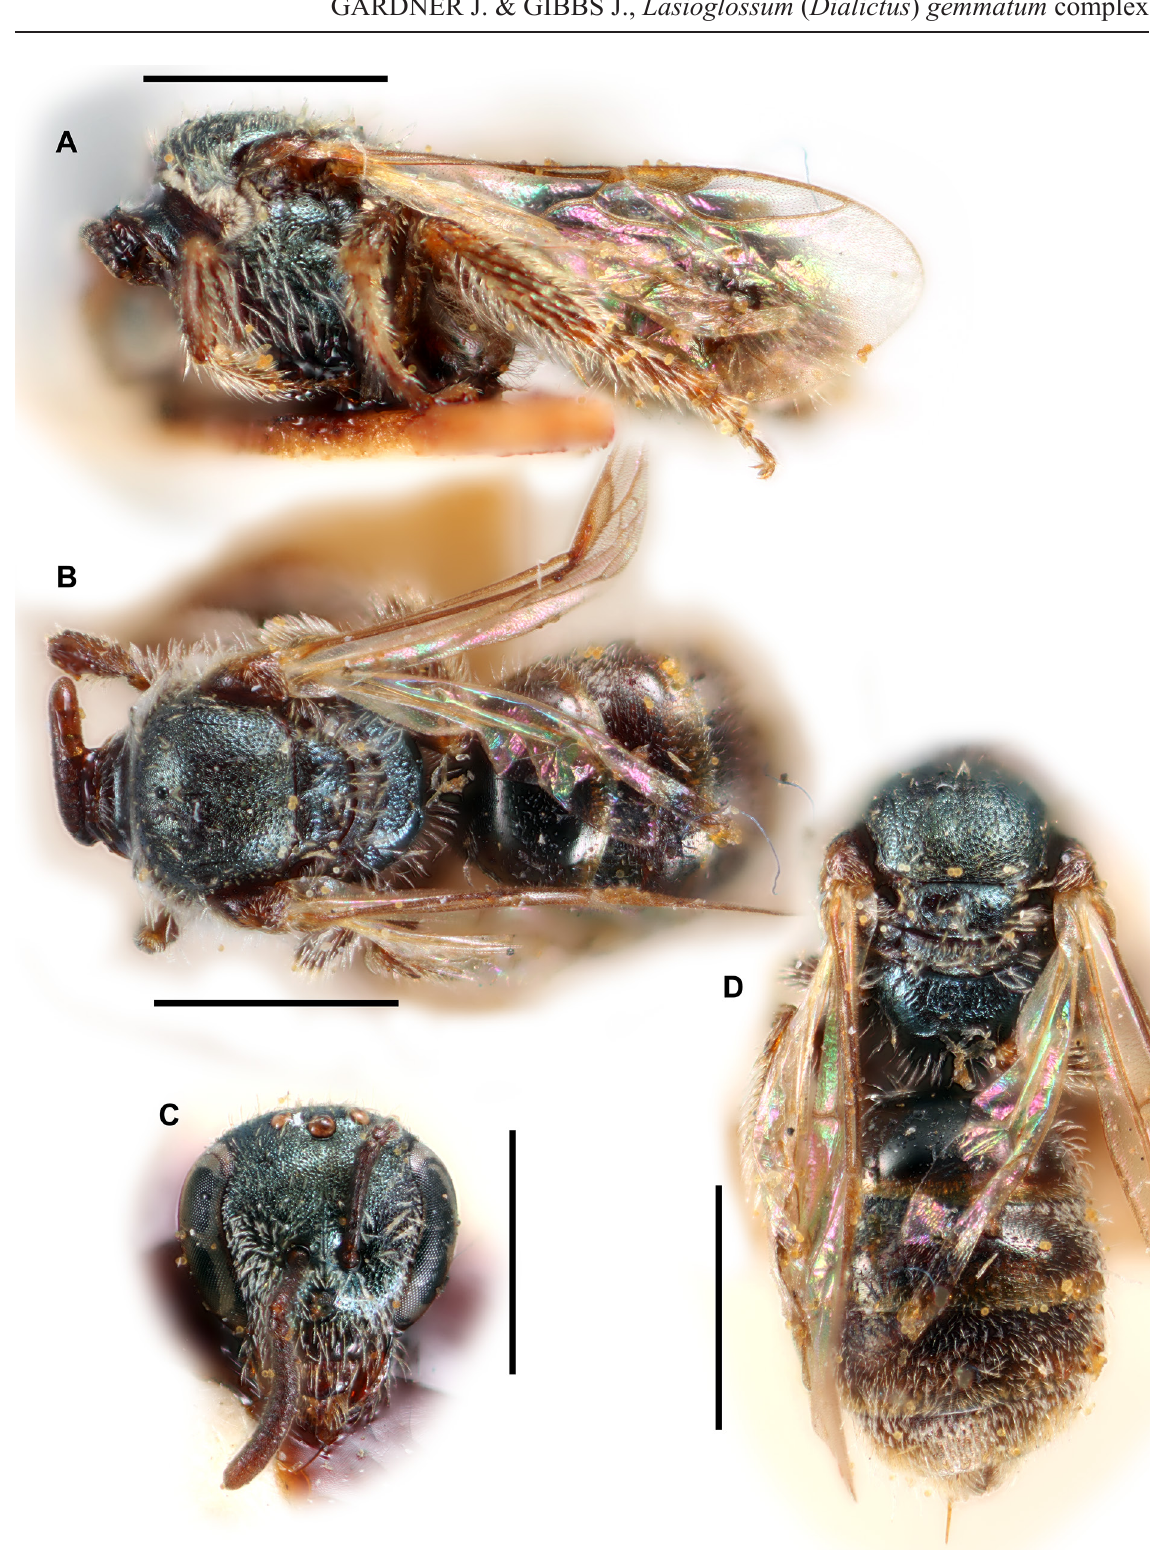
Fig. 30. Lasioglossum ( D .) helianthi (Cockerell, 1916), ♀, holotype (USNM). A . Lateral habitus. B . Dorsal habitus. C . Face. D . Metasoma and propodeum. Scale bars = 1